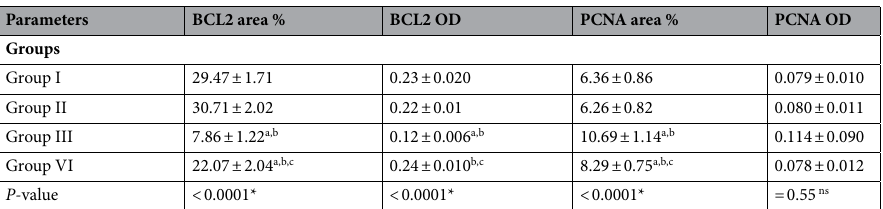
Table 2. The area percent of BCL2 immunoreaction (BCL2 area %), BCL2 optical density (BCL2 OD), area percent of PCNA immunoreaction (PCNA area %) and PCNA optical density (PCNA OD) of the studied groups. Data are represented as Mean ± SD (n = 20). *Means statistically significant difference. ns means non- significant difference. a Statistically significant as compared with group I, P < 0.05. b Statistically significant as compared with group II, P < 0.05. c Statistically significant as compared with group III, P < 0.05.